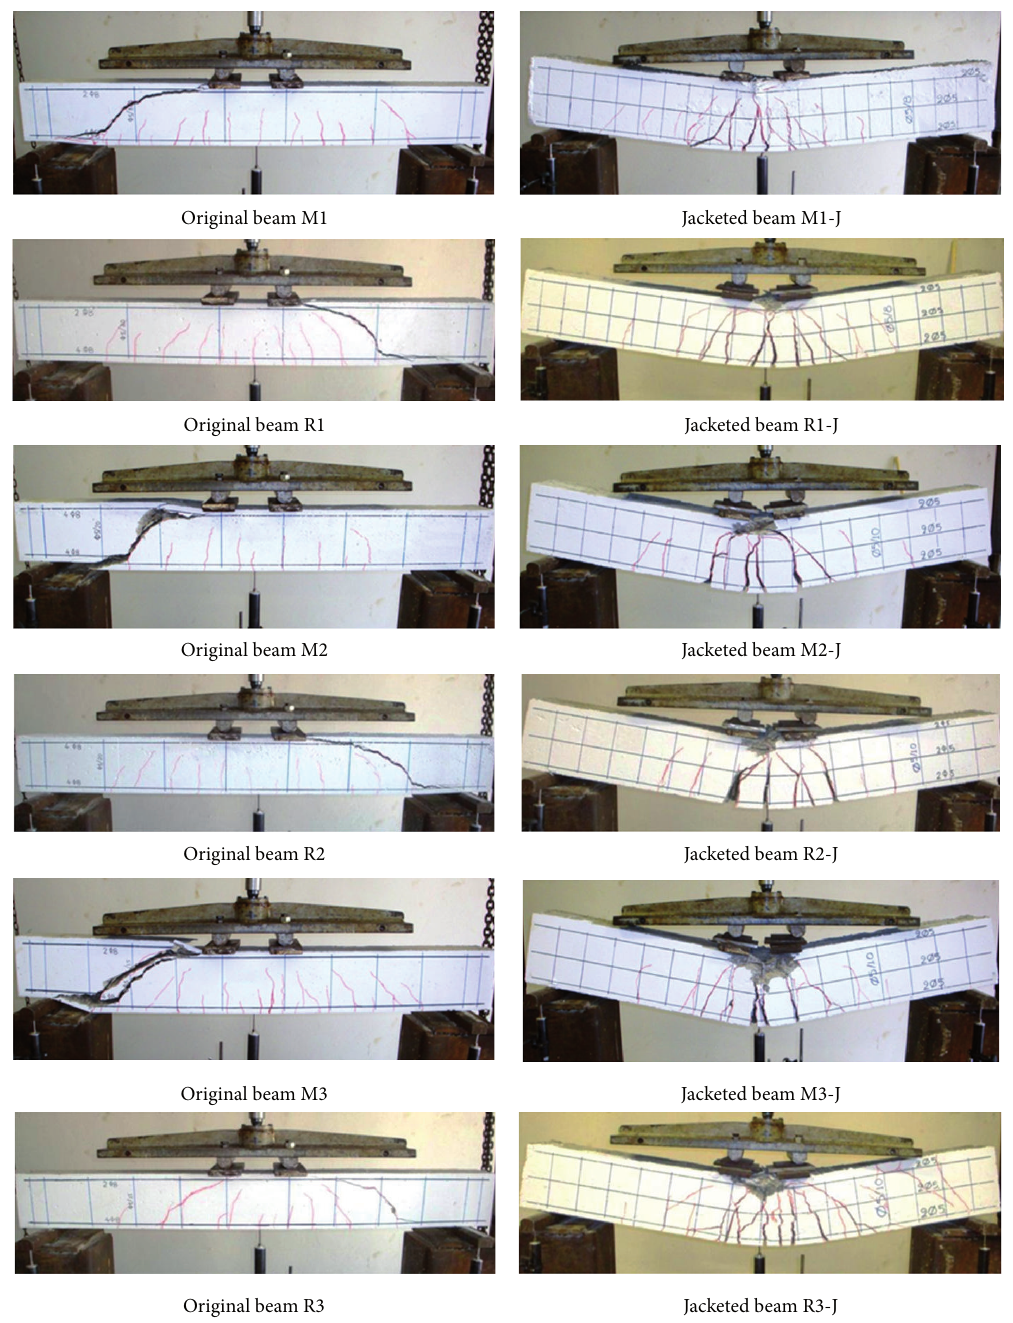
F 8: Cracking patterns of the original and the jacketed